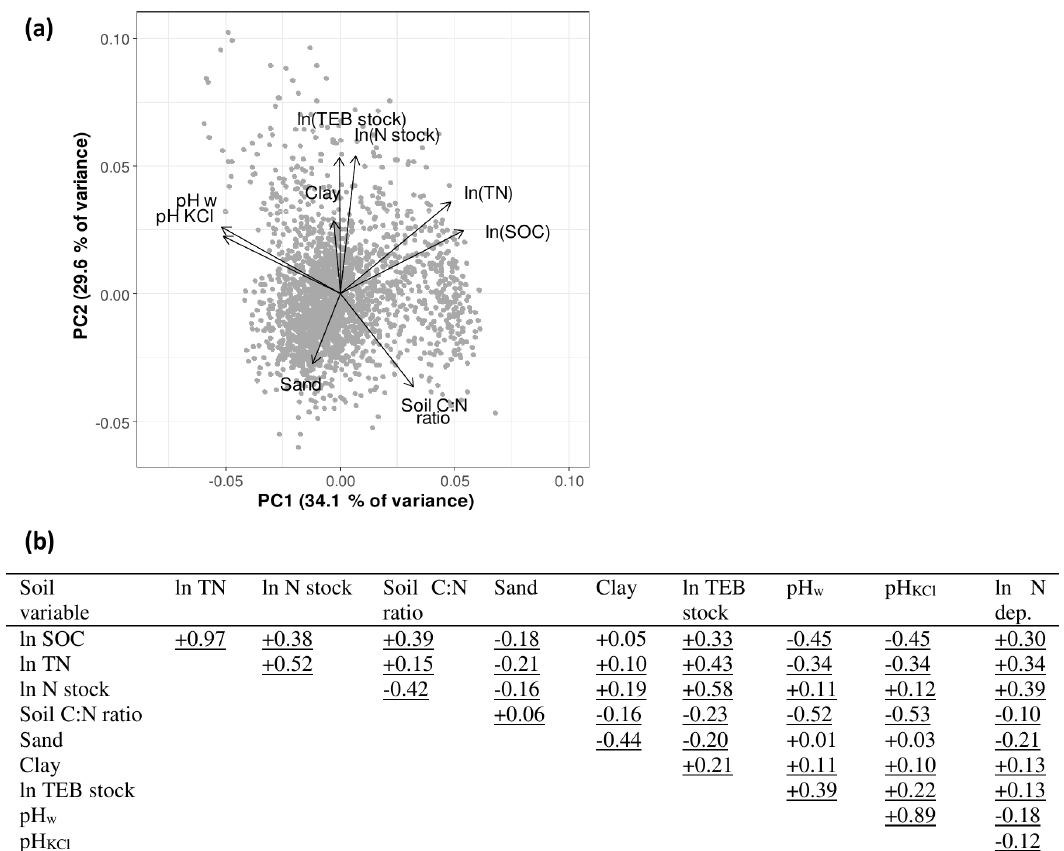
Figure 4. Correlation structure of a set of potential key soil variables for a soil depth of 0–20cm. Panel (a) shows the principal component analysis (PCA) biplot (SD for PC1 = 1.75, SD for PC2 = 1.63); panel (b) shows the correlation matrix, showing Pearson’s r for the variable pairs, including correlations with nitrogen deposition. Underlined correlations were significant. Abbreviations: SOC: soil organic carbon concentration (%); TN: soil total nitrogen (%); N stock: amount of nitrogen in the layer (gm − 2 ); Soil C:N ratio: soil carbon-to-nitrogen ratio; Sand: percentage of sand in the mineral soil; Clay: percentage of clay in the mineral soil; TEB: total exchangeable bases (cmol + m − 2 ); pH w : pH measured in water; pH KCl : pH measured in KCl solution; N dep: nitrogen